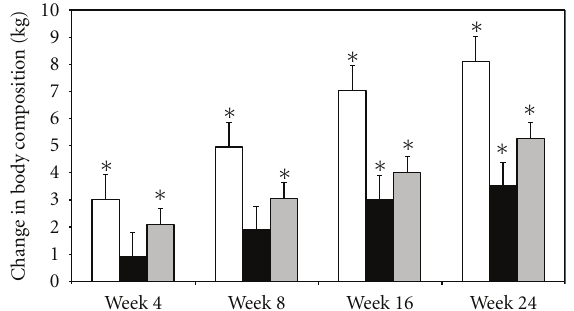
Figure 2: Change in body mass. The change in weight is shown by open bars and fat-free mass by black bars and fat mass by gray bars at each time point compared to baseline. Whiskers represent standard errors. ∗ represent significant change ( P < 0.05) compared to baseline.